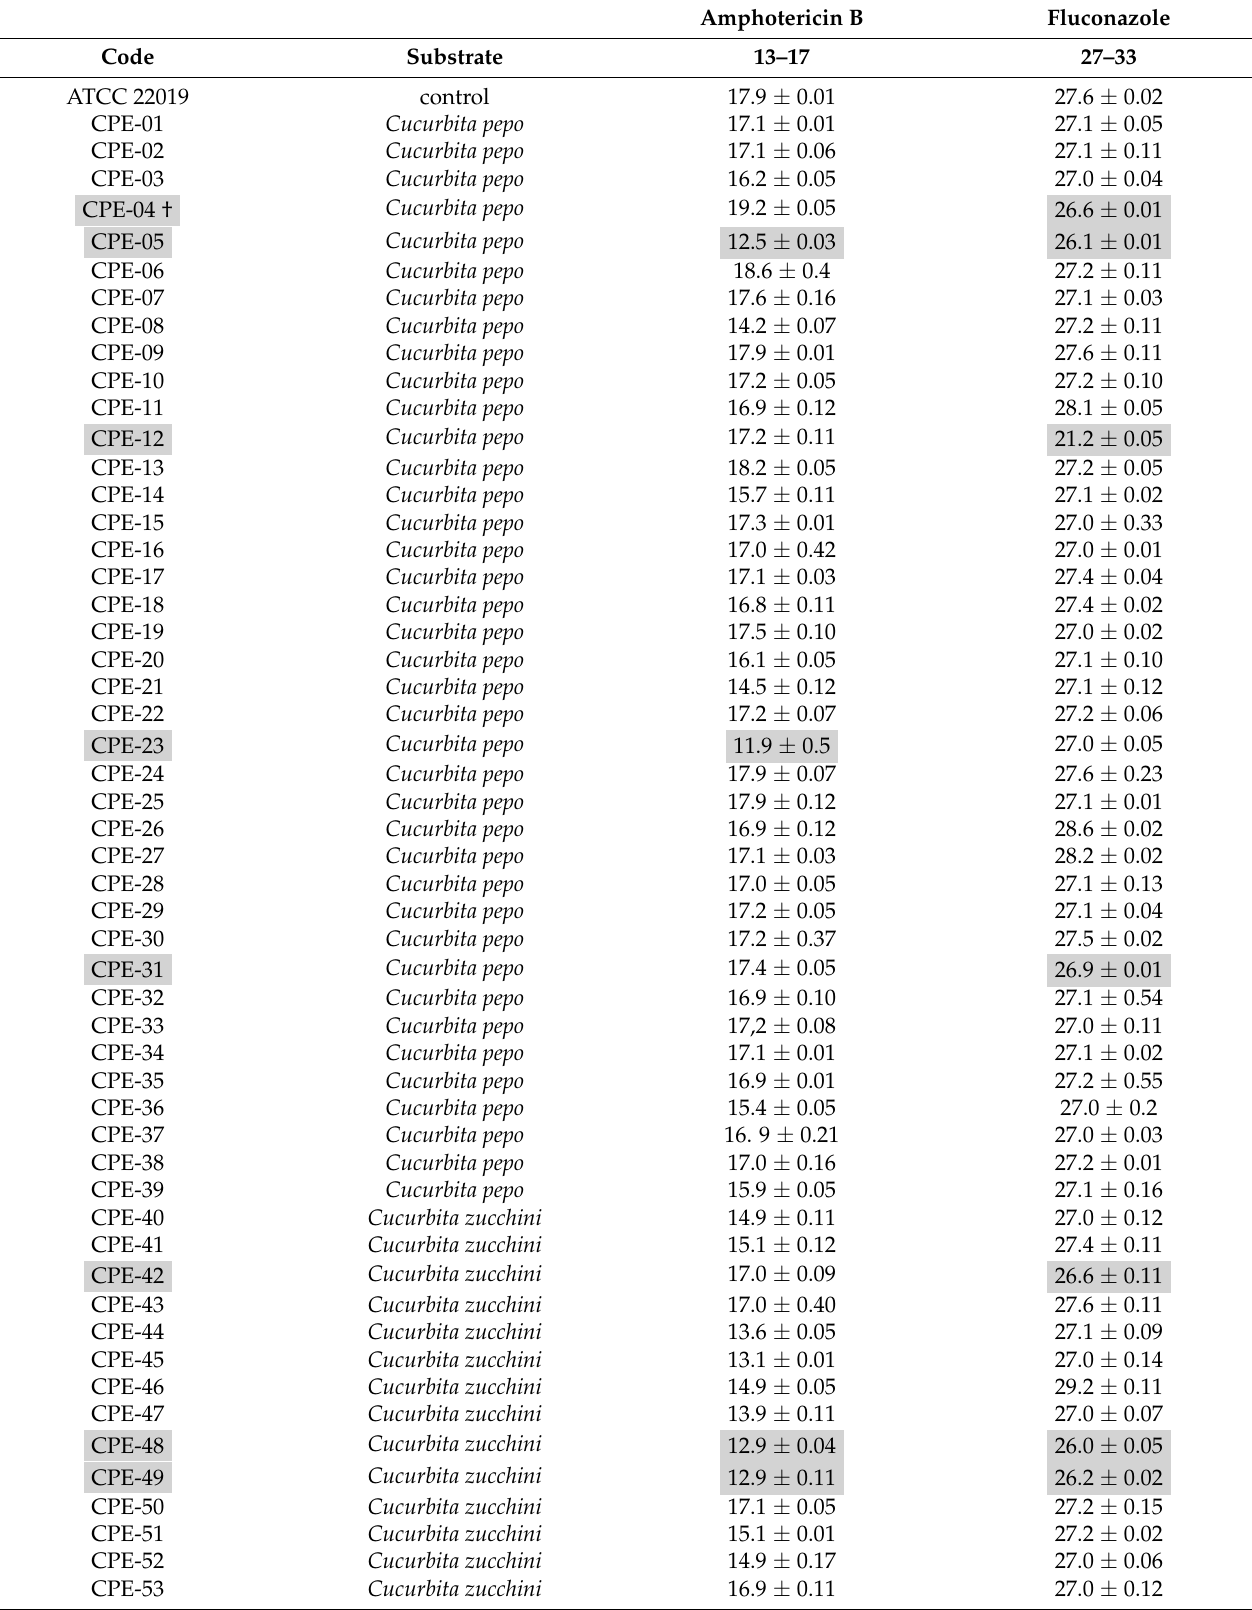
Table 4. Endophytic strains of Candida parapsilosis isolated from ripe vegetables and fruits with antimycotic susceptibility (retarded growth with standard errors,